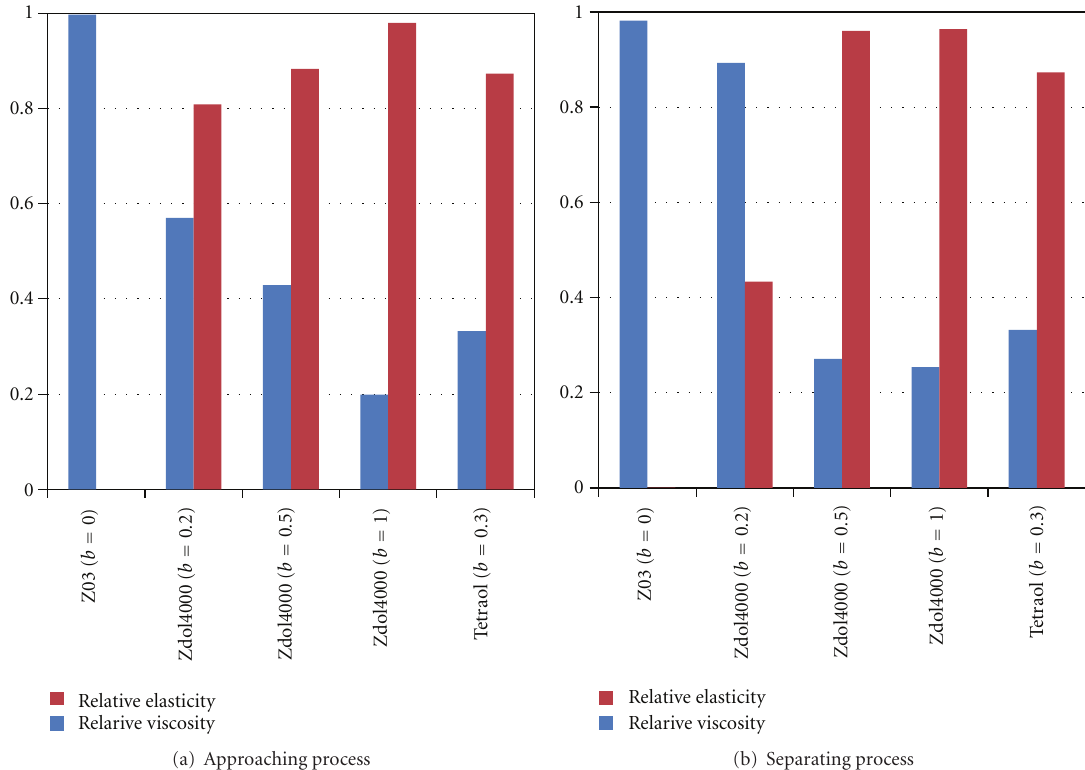
Figure 15: Relative viscosity and elasticity measured with di ff erent samples in (a) approaching and (b) separating processes.